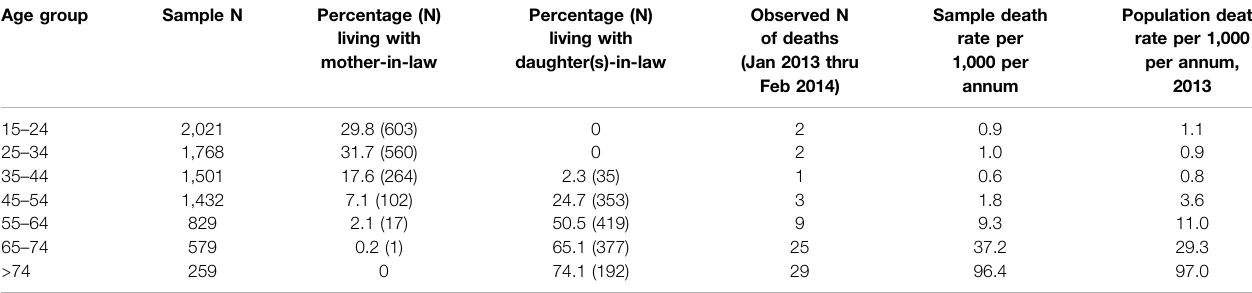
TABLE 1 | Sample size, living arrangements, and death rates, by age group, in the 10% sample of Matlab women. Age